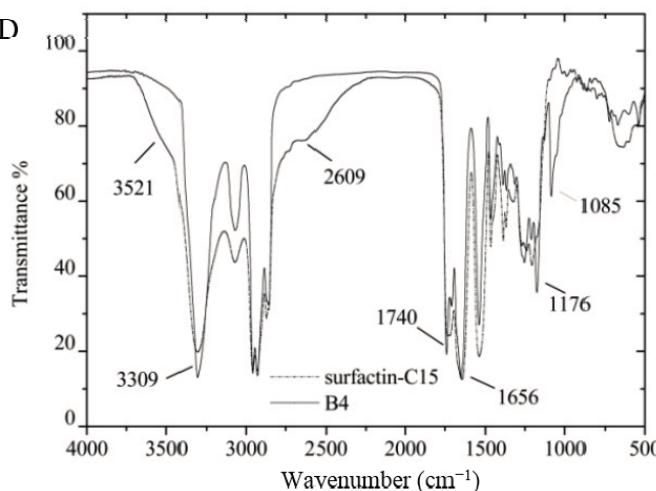
Figure 3. Fourier transform infrared spectroscopy (FT-IR) results of surfactin-C14, surfactin-C15, B1, B2, B3 and B4. ( A ) for surfactin-C14 and mono-hexyl-surfactin C14 ester; ( B ) for surfactin-C15 and mono-hexyl-surfactin C15 ester; ( C ) for surfactin-C14 and di -hexyl-surfactin C14 ester; and ( D ) for surfactin-C15 and di -hexyl-surfactin C15 ester.